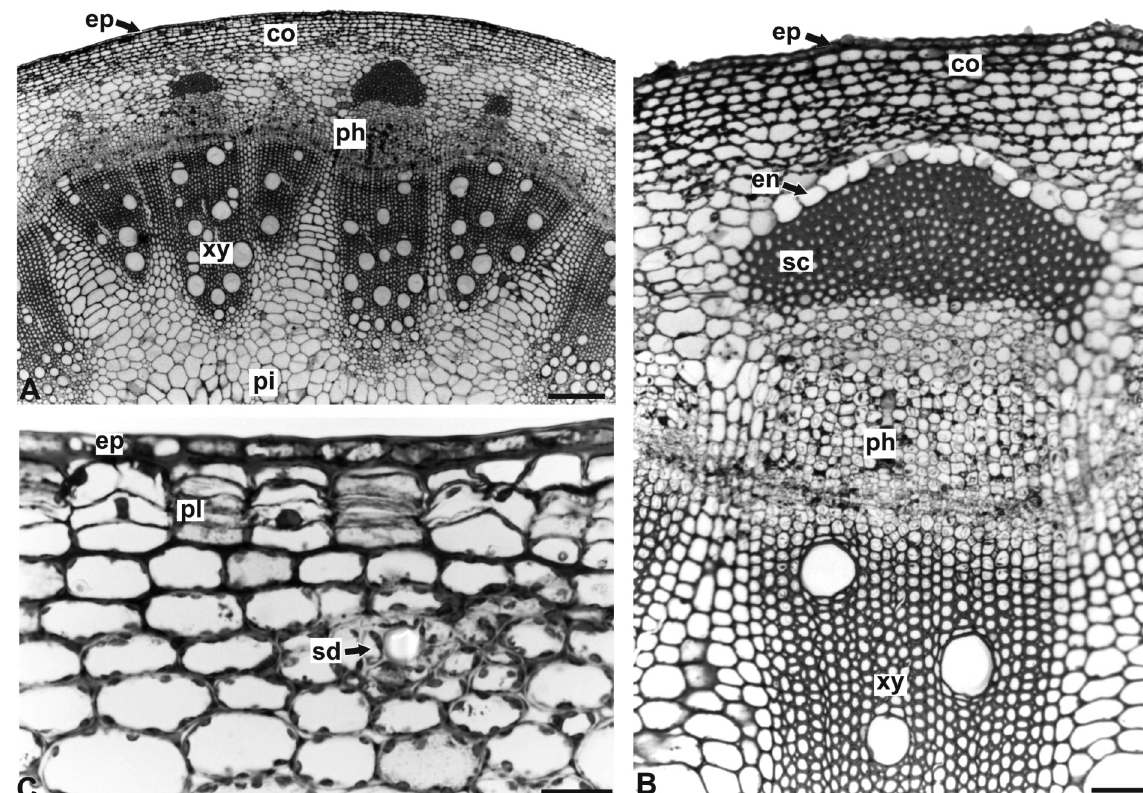
FIGURE 4 - A-C : Tithonia diver/sifolia (Hemsl.) A. Gray – stem in transverse section: A . Overall organization; B . Epidermis, cortex and vascular cylinder aspect; C . Detail of the superficial phellogen onset. Abbreviations: co - collenchyma, en - endodermis, ep - epidermis, ph – phloem, pl – phellogen, sc - sclerenchymatic cap, sd – secretory duct, xy - xylem. Bar = 200 m m (A), 50 m m (B), 20 m m